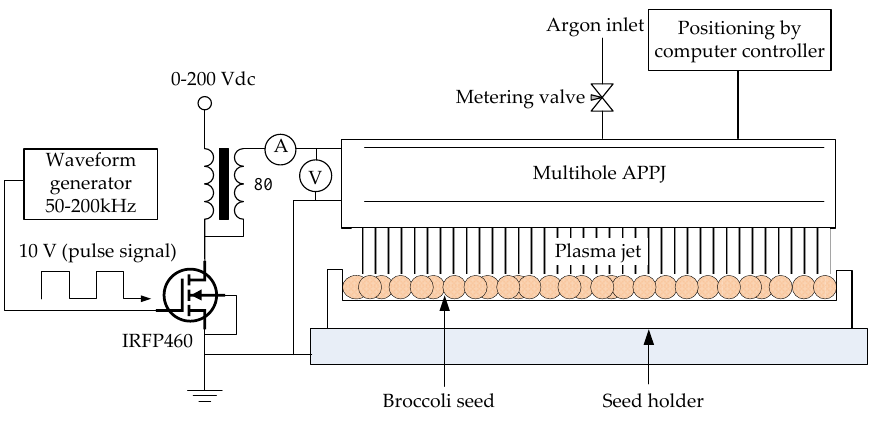
Figure 1. Schematic diagram of the experimental apparatus.